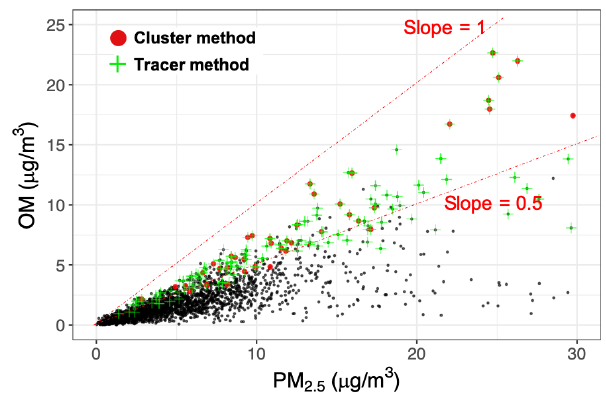
Figure 7. Scatter plot comparing total PM 2 . 5 and OM mass in atmo- spheric samples. Red circles indicate residential wood burning and wildfire samples identified by cluster analysis (Bürki et al., 2020). Green crosses show burning samples identified based on lignin and levoglucosan signatures. Black circles indicate the existing atmo- spheric samples in the IMPROVE network (2011 and 2013; approx- imately 3050 samples). The dash-dotted lines delineate the range of OM mass fractions for samples designated as burning-influenced (the slope of 0.5 is arbitrarily chosen to guide the eye). OM was es- timated by multiplying OC by 1.8 (assuming an average OM : OC ratio of 1.8). Refer to Fig. S14 for a more detailed